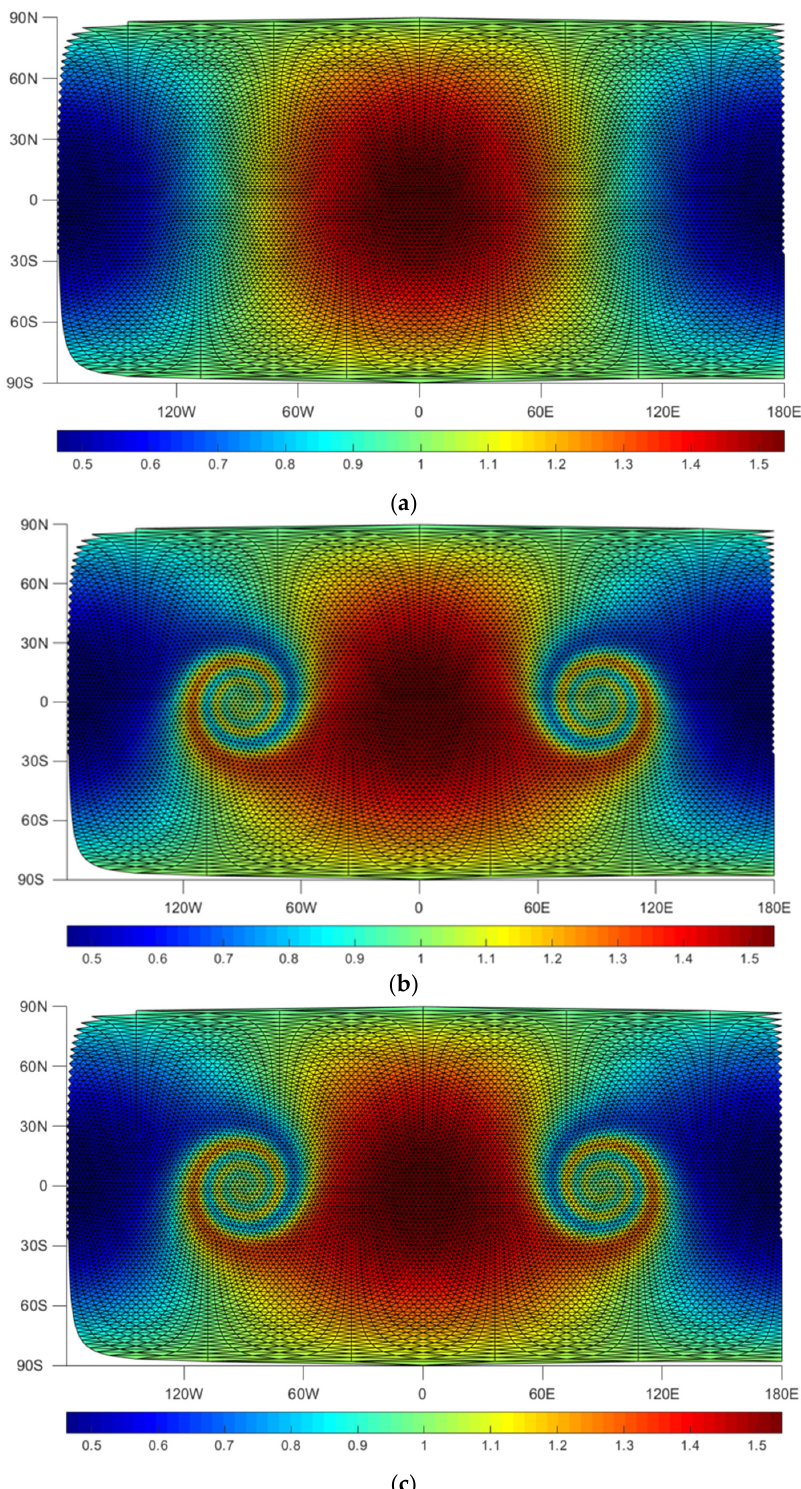
Figure 10. Moving vortex ( a ) initial scalar field and ( b ) analytic solution after 12 days for the moving vortex problem. The centers of the vortices are located on the equator at 90° E initially and at 90° W after 12 days. ( c ) The SL numerical solution of the scalar field after one full revolution (12 days). The SL advection scheme employs global RBF method on the icosahedron sphere mesh with refinement level 5 and the wind direction angle 𝛼 = 0, Δ 𝑡 = 0.5 , hour.